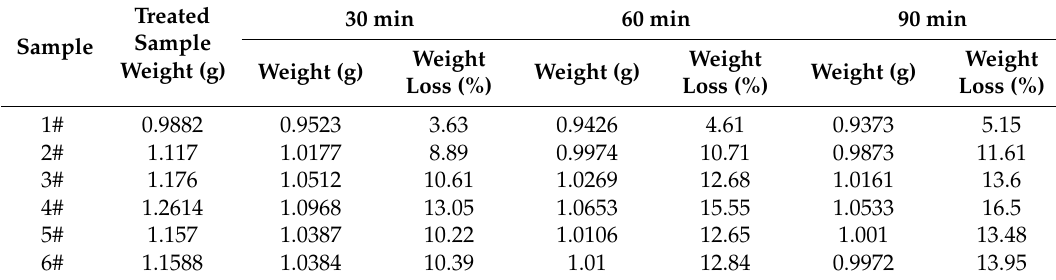
Table 3. Weight change for the different washing